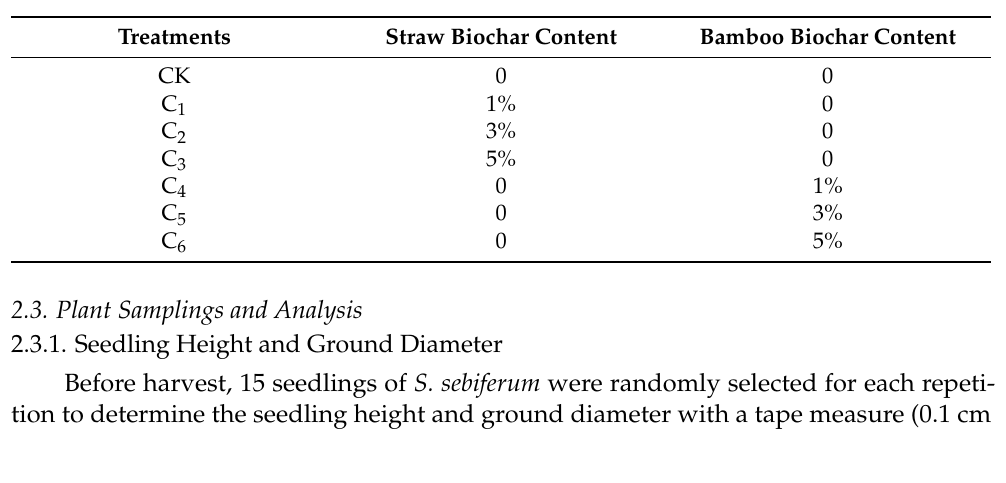
Table 1. The design of biochar